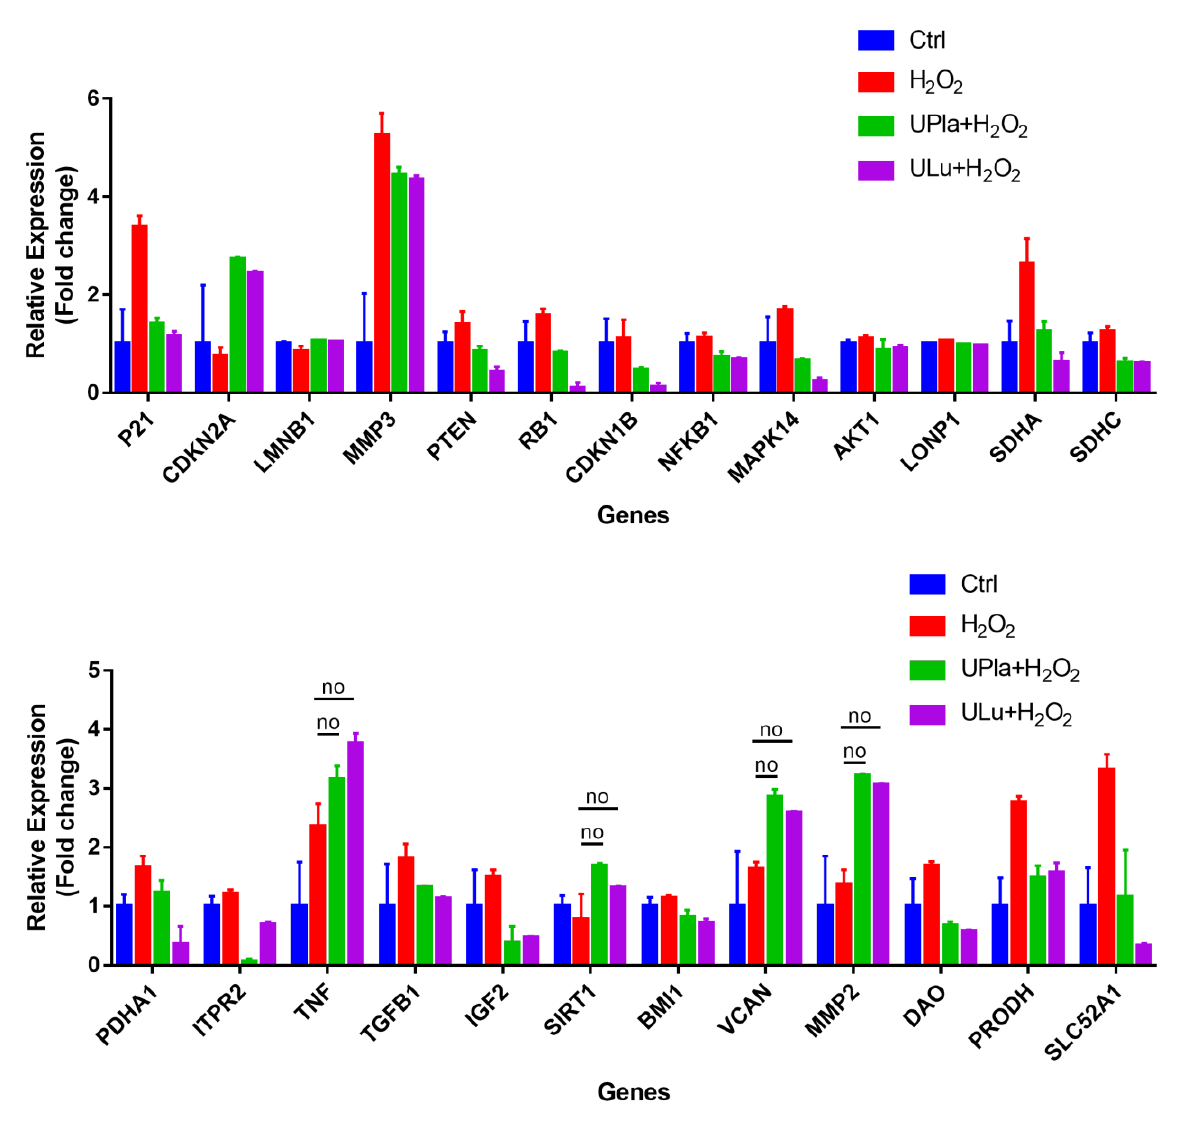
Figure 10. Gene expression profiling of H 2 O 2 -induced HepG2 senescence and modulation by UPla and ULu. Except genes labeled with “no,” the expression of all genes was significantly altered by H 2 O 2 and significantly modulated by Upla and Ulu. The results are shown as fold changes to the control groups. The results are expressed as the mean ± SD from three sets of independent samples. Table 1. TaqMan gene assays.